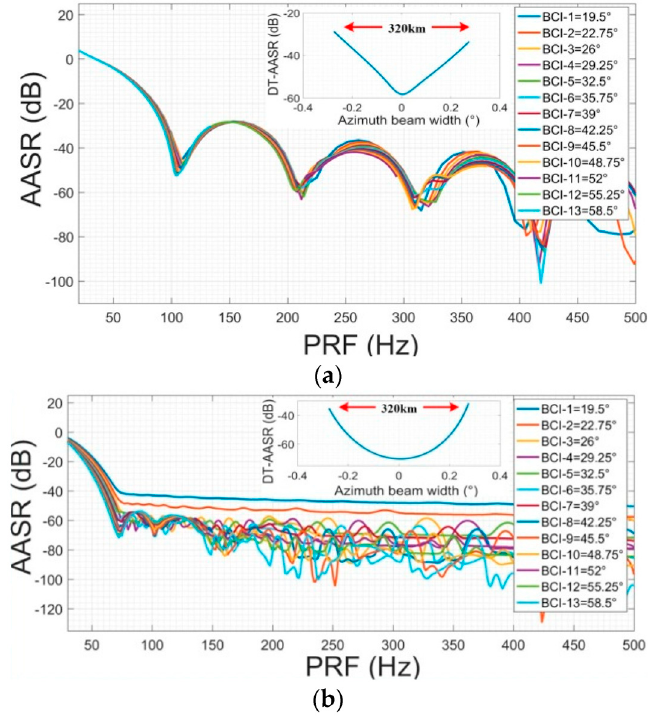
Figure 14. AASR and DT-AASR of Geo-SAR at a latitude argument of 23.4 ◦ . ( a ) Broadside, latitude Table 1. Simulation parameters of GF-3 and Geo-SAR. argument of 23.4 ◦ . ( b ) 60 ◦ squint, latitude argument of 23.4 ◦ .